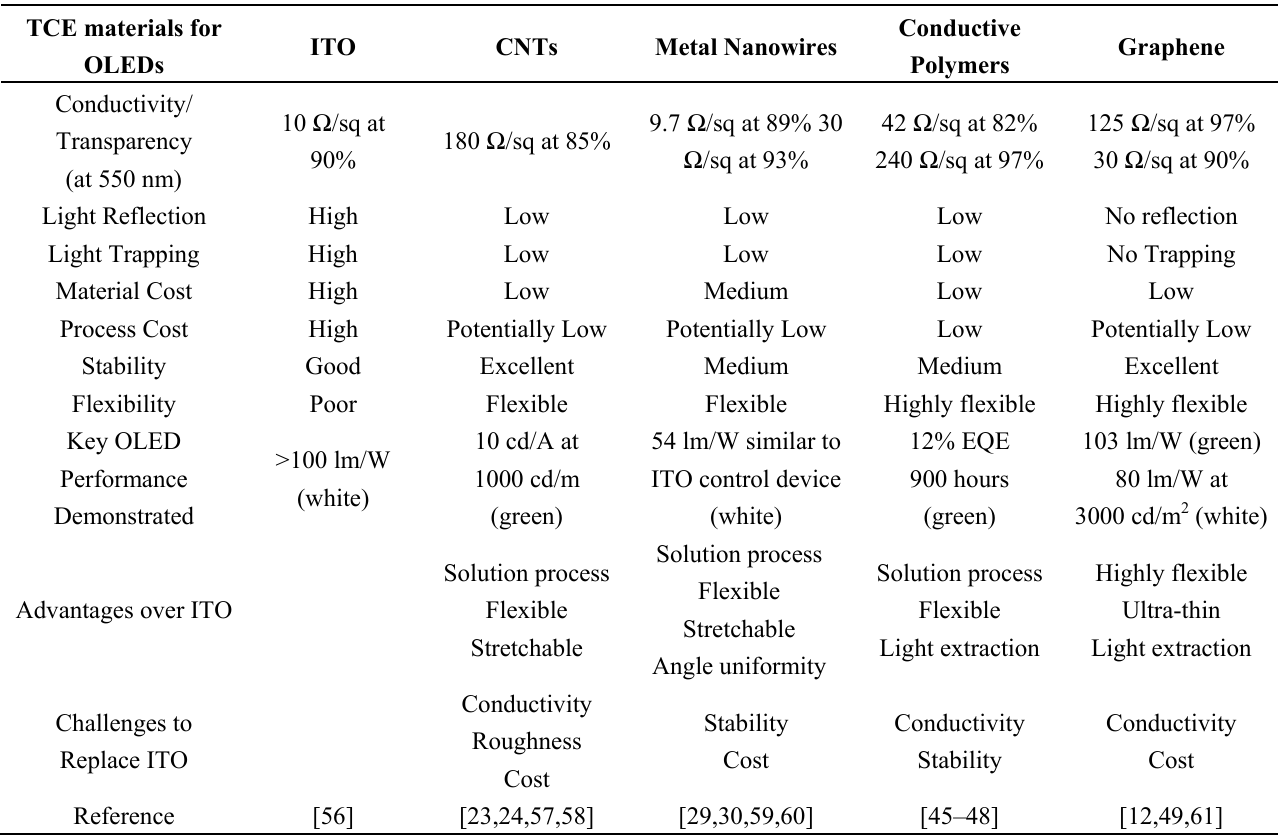
Table 1. Comparison of the TCE